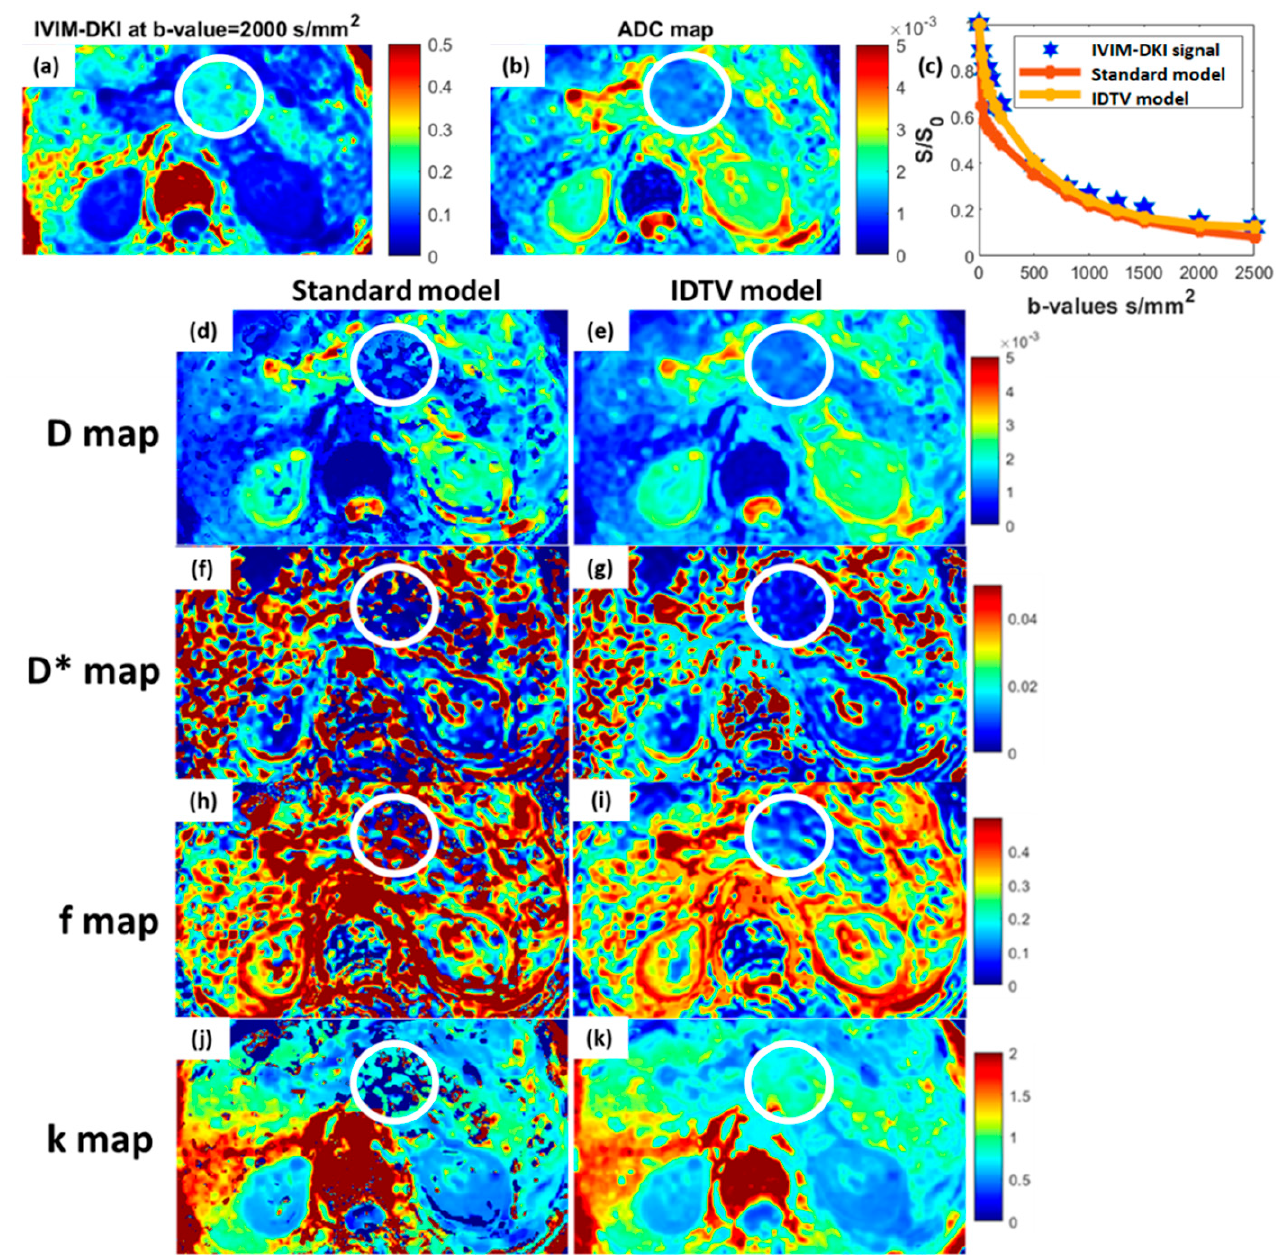
Figure 3. Representative image of a 72 − year − old male patient with PDAC demonstrating qualitative comparison between parameter maps estimated using standard ( d , f , h , j ) and IDTV ( e , g , i , k ) models. The encircled zone (white) represents the tumor − affected region, and the IDTV model successfully eliminated noise from the parameter maps when compared to the standard approach and ( c ) accurately curve fitting the mean of the IVIM-DKI signal decay for the tumor region. ( a ) IVIM-DKI image at b = 2000 mm 2 /s appears hyperintense in encircled region and ( b ) hypointense in corresponding region in ADC map. ( k ) In k map, hyperintensity was seen in tumor region, while ( e , g , i ) hypointensity was observed in D, D*, and f maps. ( d , e ) D map, ( f , g ) D*map, ( h , i ) f map, and ( j , k ) k map.